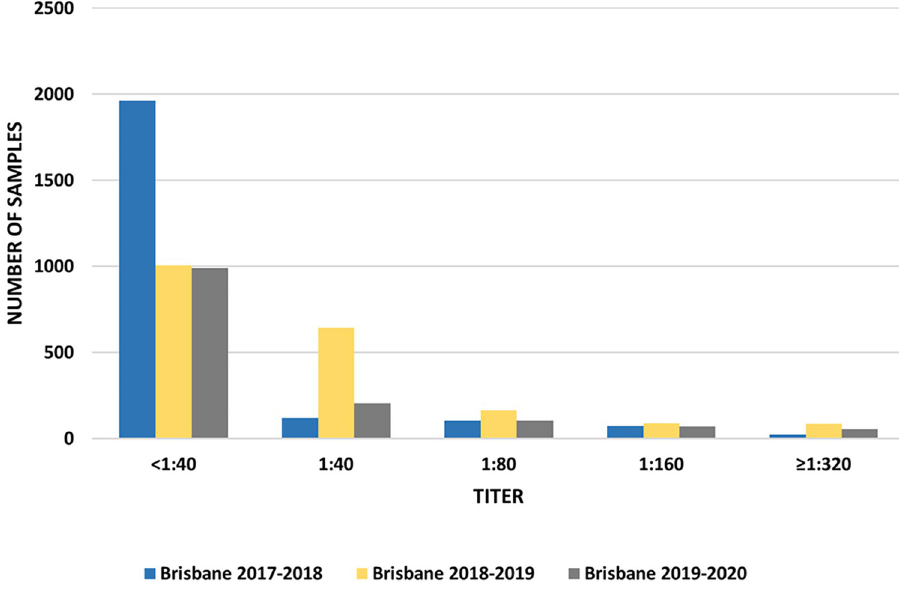
Fig 2. Titer distribution of antibodies against Victoria lineage during each season of the